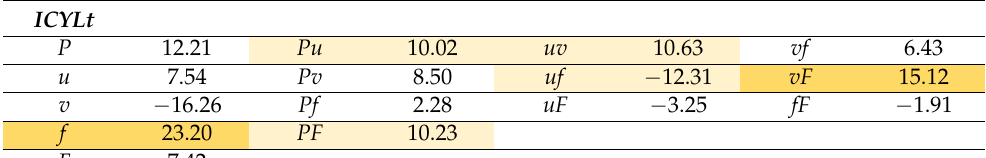
Table 5. Main effects and interactions of experimental factors regarding the improvement ratio of cylindricity ( ICYLt